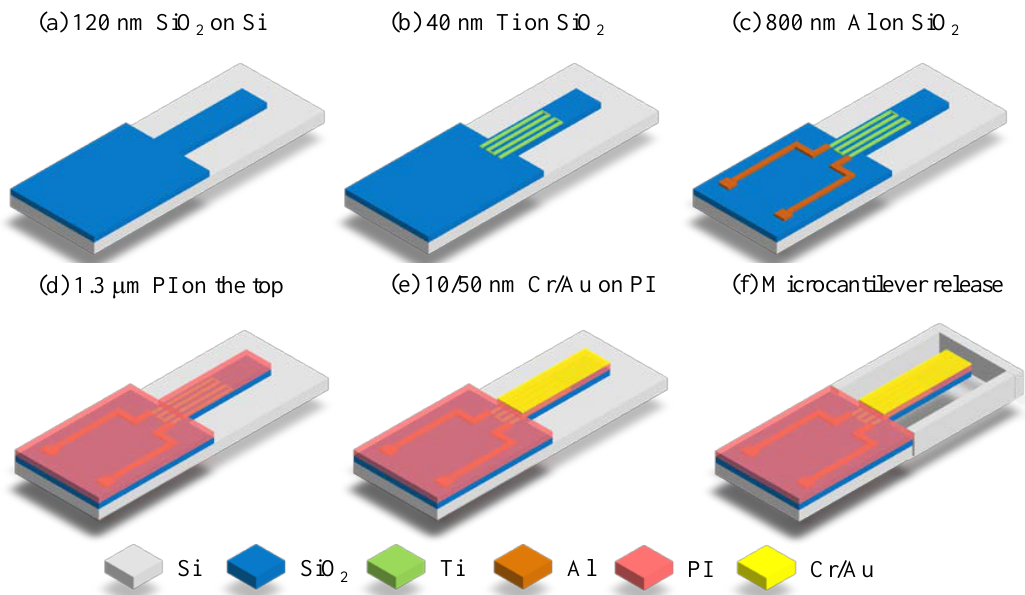
Figure 2. The fabrication processes of PI / Ti / SiO2 microcantilevers. ( a ) LPCVD technology was used to deposit 100 nm SiO 2 . ( b ) Sputtering was used to make 40 nm thick Titanium piezoresistor. ( c ) Sputtering was used to deposit 800 nm thick Al pad. ( d ) Spin coating was implemented to make 1.3 µ m thick PI. ( e ) Sputtering was used to deposit 10 / 50 nmthick Cr / Au modified layer. ( f ) A combination of anisotropic and isotropic dry etching techniques was used to etch the silicon wafer until the microcantilever structure is completely released.